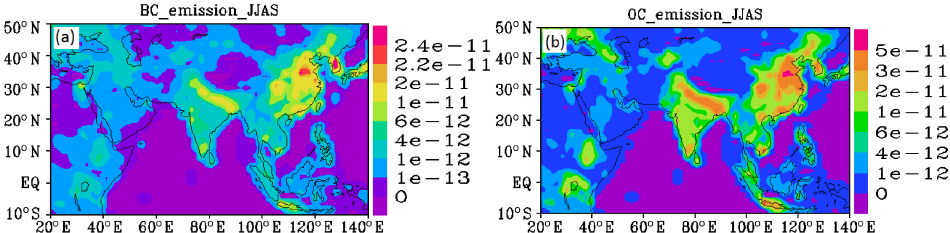
Figure 1. Distribution of emission mass flux (kgm − 2 s − 1 ) averaged for the monsoon season (June–September) for (a) BC and (b) OC